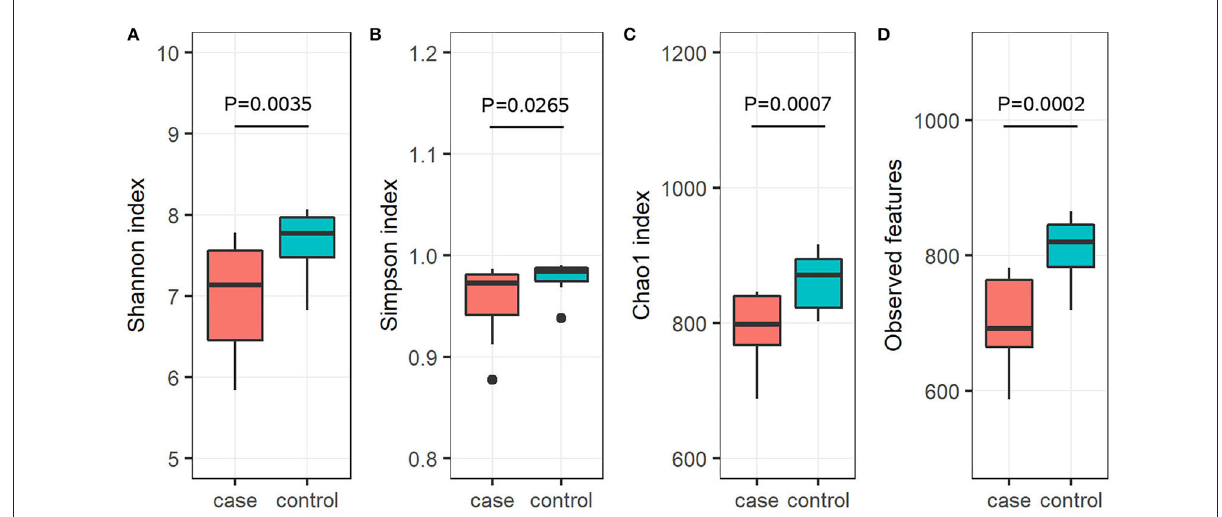
FIGURE1 Gut microbial alpha diversity analysis. Diversity in the gut microbiota community was measured using the Shannon index (A) , the Simpson index (B) , the Chao1 index (C) , and observed features (D) . The bottom and top of each box are the first and third quartiles, respectively, and the band inside the box is the